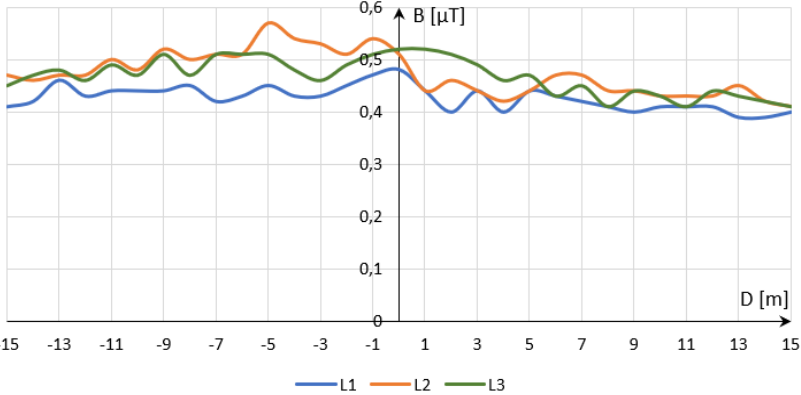
Figure 6. Distribution of magnetic field induction B along L1, L2, L3 phase conductors of the 15 kV power line No. 1, ELF frequency range.